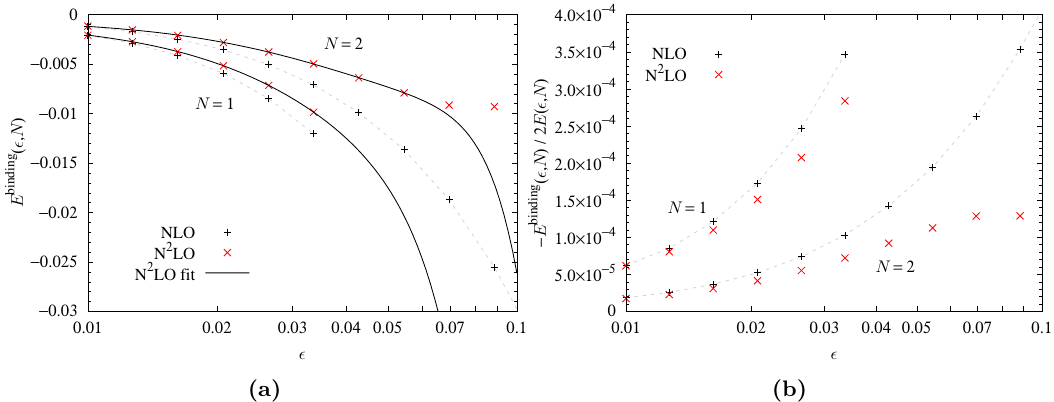
Figure 21 . (a) Binding energy as a function of (cid:15) in form of a single “bond” between two N = 1 , 2 baby Skyrmions. The red crosses are the N 2 LO results, while the black pluses are the NLO results shown for reference. For N = 1 the data is truncated at (cid:15) ∼ 0 . 033 since the two composite N = 1 baby Skyrmions side-by-side become unstable and will merge. The black solid lines are the fits given in eq. (5.16). (b) Binding energy between the two charge- N baby Skyrmions divided by the total energy of the two charge- N baby Skyrmions.